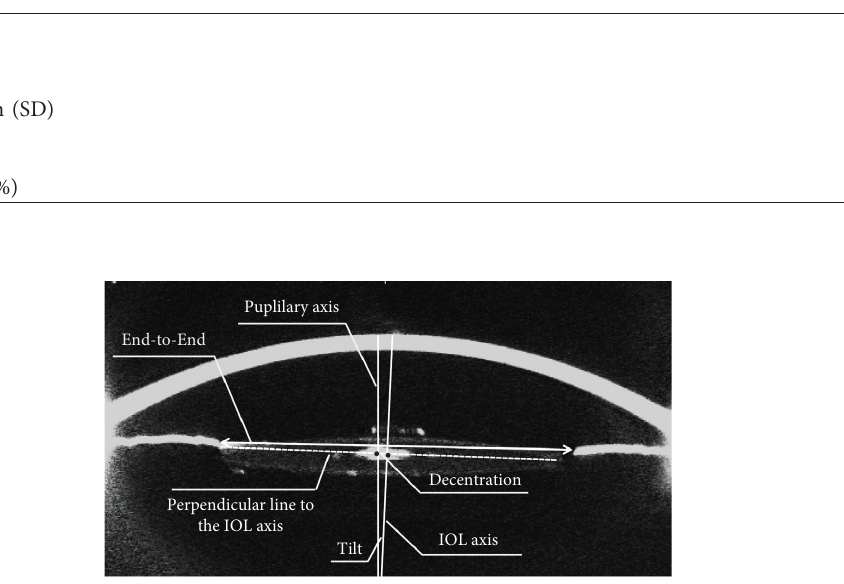
Figure 1: Fitted circumferences, pupillary axis, and IOL axis merged on a Scheimpflug cross-section image. Decentration is calculated from the distance between the IOL axis and pupillary axis. The IOL tilt was calculated from the angle between the axes.